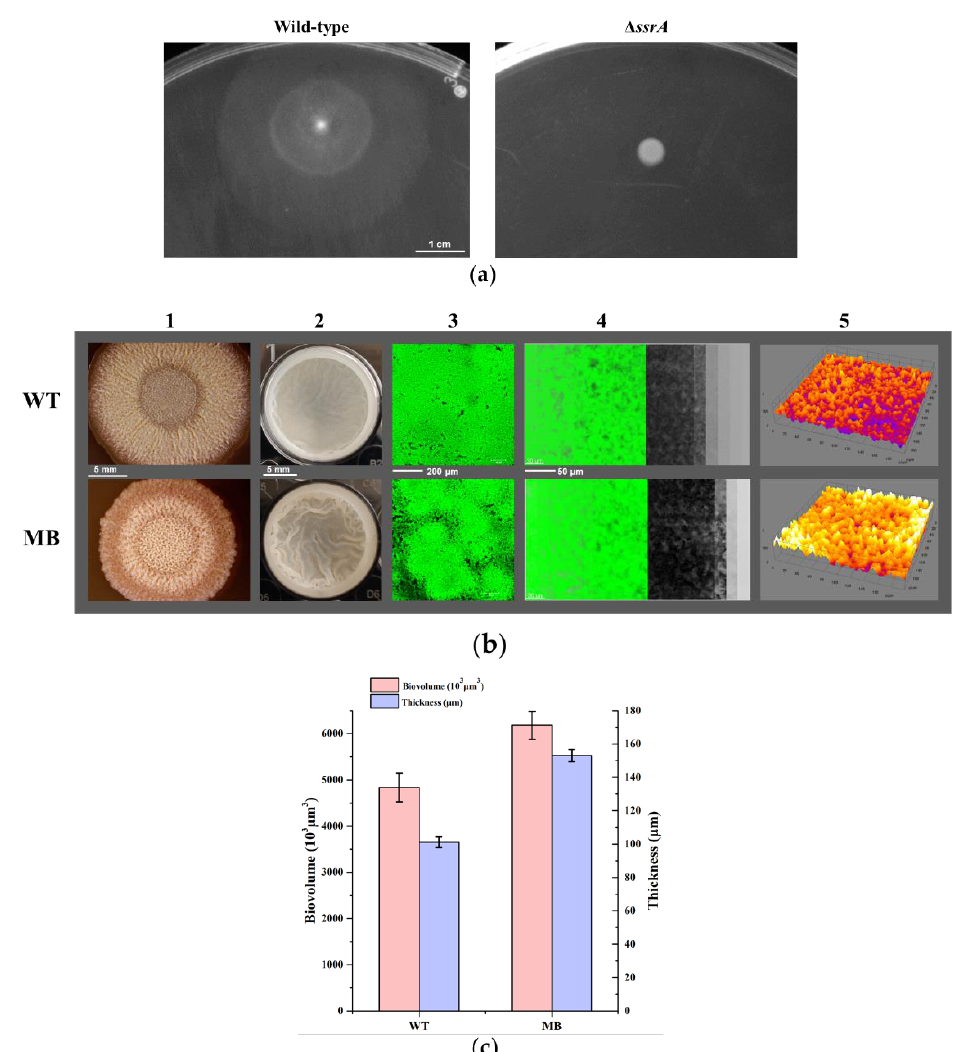
Figure 2. Screening for the suppressor(s) of ssrA that possesses restored biofilm formation ability. ( a ) To test the swarming motility, WT and TM were grown in soft agar plates (0.65% agar) for 6 h at 37 °C. The scale bar represents 1 cm. The images shown are the representatives of three independent experiments. ( b ) The WT and MB strains were grown in the MSgg agar plates for 3 days (Lane 1) and in 24-well microtiter plates supplied with the LBMG liquid medium for 48 h (Lane 2), and biofilms produced by the strains were observed. The images shown in Lane 1 and Lane 2 are the representatives of three independent experiments. Biofilms formed in the microtiter plates were stained with SYTO ® 9 and investigated using CLSM. Images of cells attached to the surface were shown in Lane 3. The confocal series were reconstructed through the software IMARIS and a representative image (left) with virtual shadow projection (right) is shown for each strain in Lane 4. The 3D models of biofilms formed by these two strains are shown in Lane 5. The scale bars in Lane 1 – 4 represent 5 mm, 5 mm, 200 μm, and 50 μm, respectively. ( c ) Quantification of the thickness and biovolume of the submerged biofilms produced by WT and MB. The biovolume (purple) and the average thickness (pink) were calculated as the average and S.D. of a six-image series for each strain.